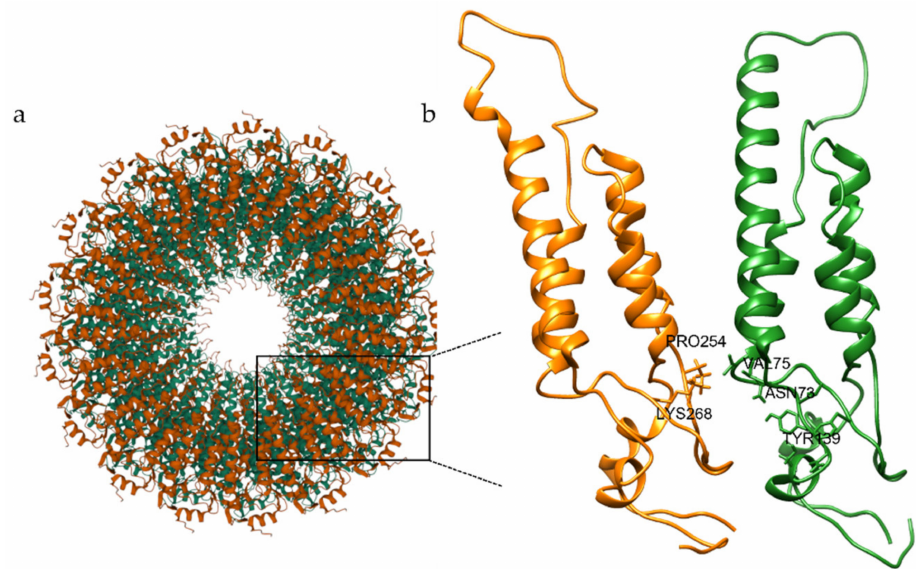
Figure 1. Crystal structure and active site of TMV CP. ( a ) The 20S disk is a four-layer cylindrical structure with 17 CP molecules in each ring [59,60]. ( b ) Architecture of the two CP subunits (chain A in green and chain B in orange) depicting the binding site residues in between